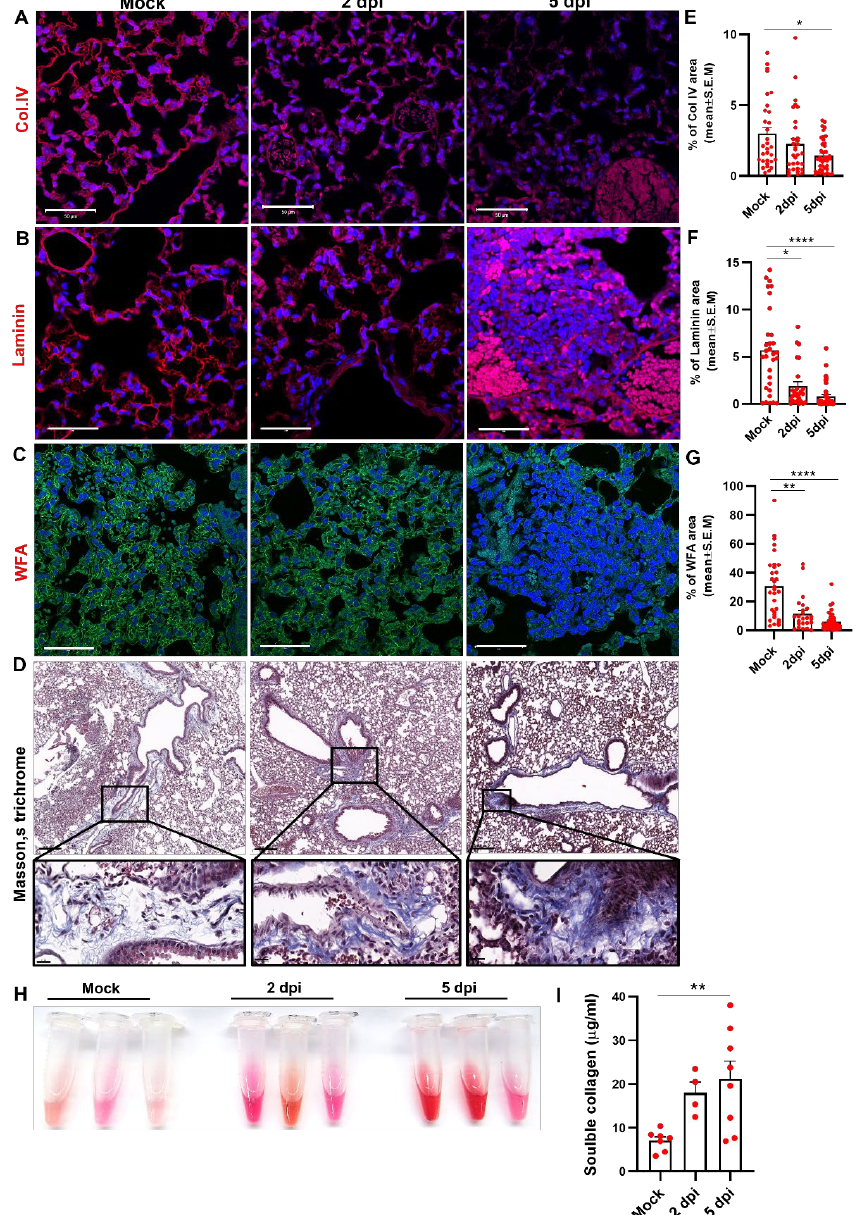
Figure 4. SARS-CoV-2 infection induce lung ECM remodeling in K18-hACE-2 mice. Representative images and the corresponding quantification of lung sections labeled for collagen IV ( A , E ), laminin ( B , F ), WFA ( C , G ) and Masson’s trichrome ( D ) (MTC) at 2 and 5 days post SARS-CoV-2 infection compared to mock. For each group n = 6–8 mice and for each mouse, five fields were imaged and analyzed. Scale bar: ( A – C ) 50 µm, ( D ) 200 µm, inset 20 µm. ( H ) Representative soluble collagen accumulation in BALF samples of mice 2 and 5 days post SARS-CoV-2 infection compared to mock. ( I ) Quantification of soluble collagen concentrations in the BALF samples; (n = 6 mice for mock and n = 5 for 2 dpi and n = 8 for 5 dpi). The error bars represent the SEM. Statistical significance was calculated using Kruskal–Wallis nonparametric test * p < 0.05, ** p < 0.005, **** p < 0.0001 .